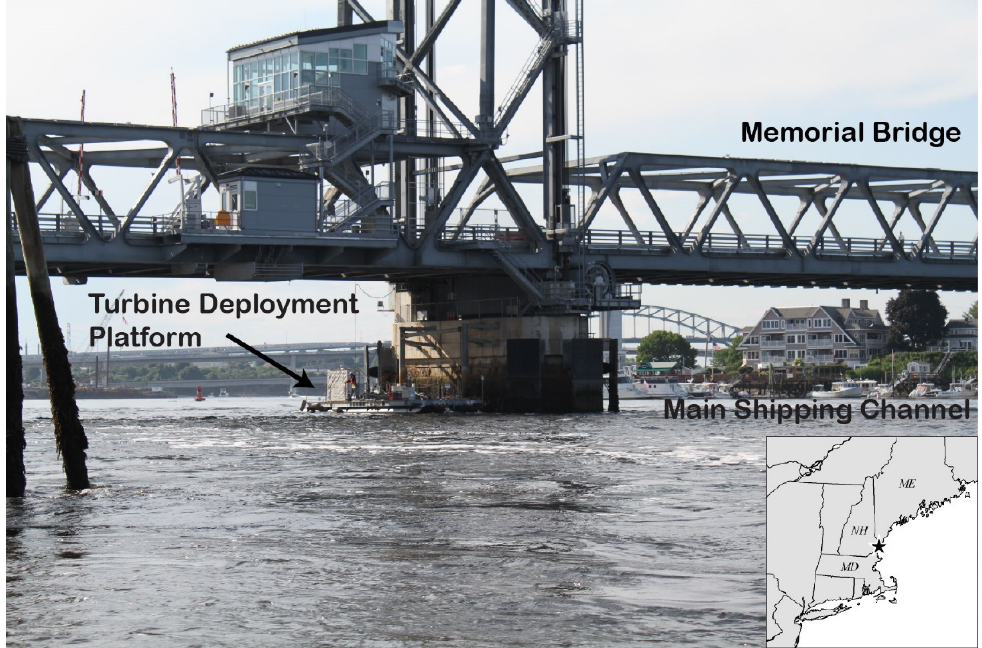
Figure 1. The University of New Hampshire’s Living Bridge Project turbine deployment platform is moored to a pier of the Memorial Bridge that spans the Piscataqua River and tidal estuary on the border of New Hampshire and Maine in the northeastern Unites States. The star in the lower right inset map represents regional reference location of the site.